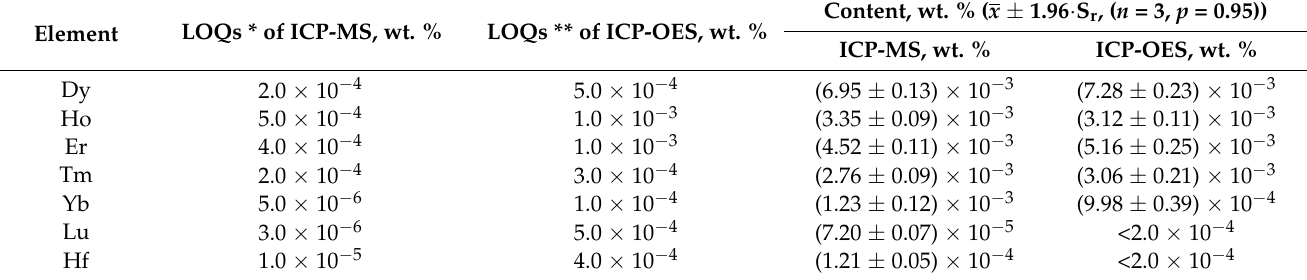
Element LOQs * of ICP-MS, wt.